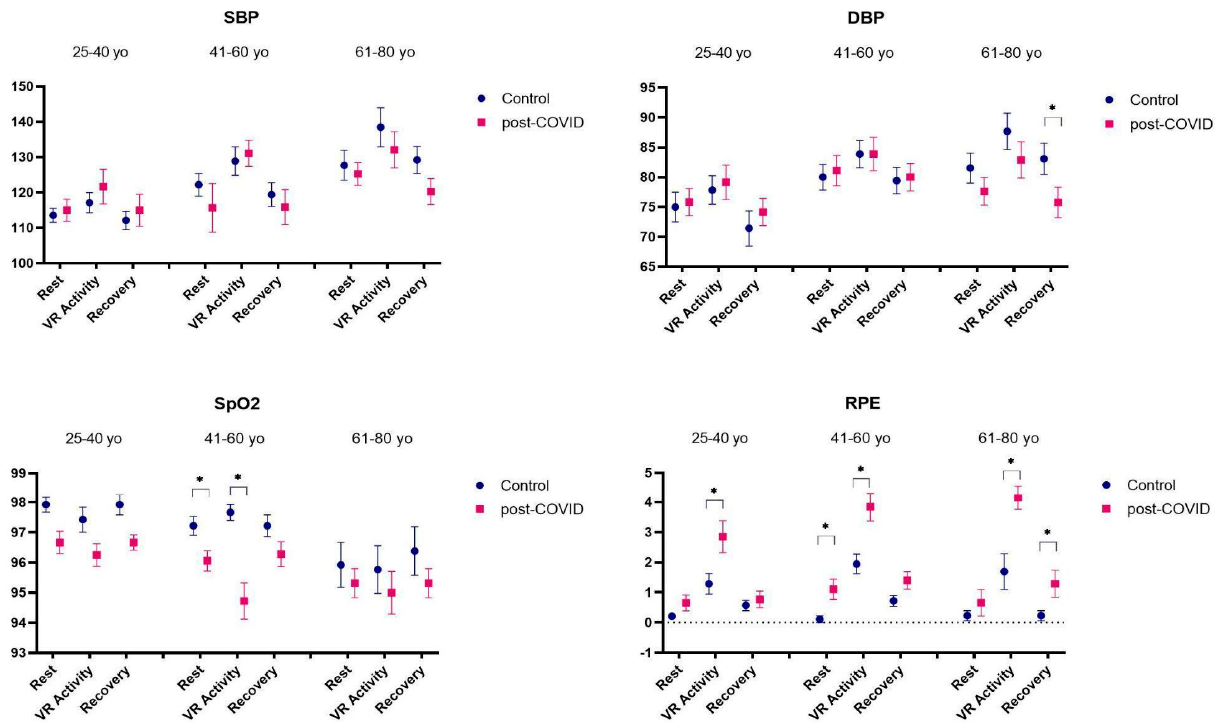
Figure 3. Representation of the mean and standard error of Physiological variables between groups (Control and post-COVID), ages (25–49 yo, 41–60 yo, and 61–80 yo), and moments (Rest, VR activity, and Recovery). yo: years-old; VR: Virtual Reality; SBP: Systolic blood pressure; DBP: Diastolic blood pressure; SpO 2 : Peripheral oxygen saturation; RPE: Rating of perceived exertion; * p < 0.05 between groups.